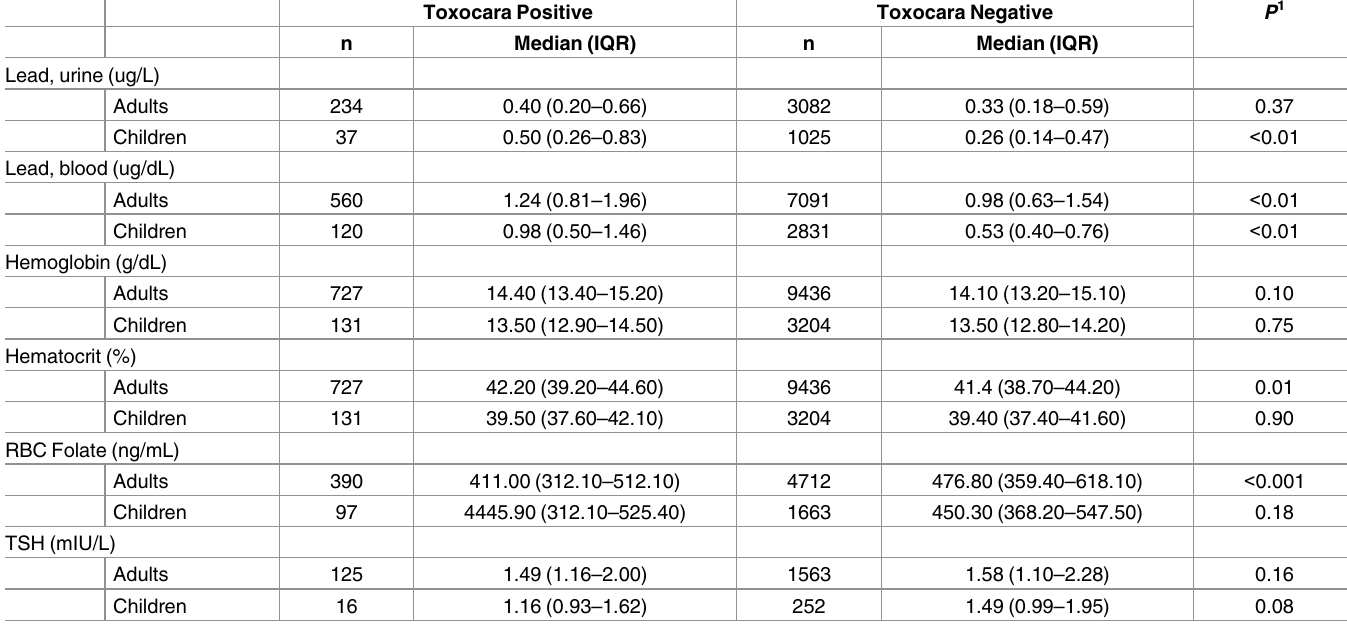
Table 4. Laboratory values by Toxocara antibody